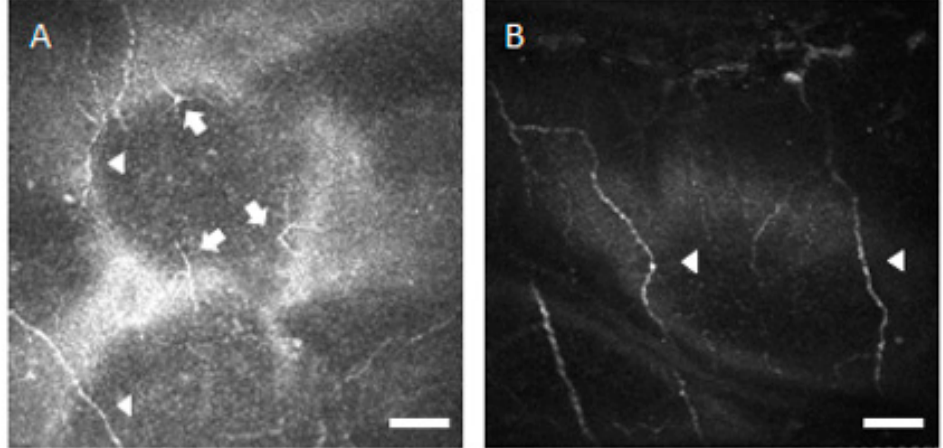
Figure 2. Representative in vivo confocal microscopic corneal sub-basal inflammatory cell images. ( A ) Image from patient with Sjögren’s syndrome shows a sub-basal nerve fiber (arrowhead) and many dendritic inflammatory cells (arrows). Bar = 50 µ m. ( B ) Image from healthy control subject shows a sub-basal nerve fiber (arrowhead) and an absence of inflammatory cells. Bar = 50 µ m.